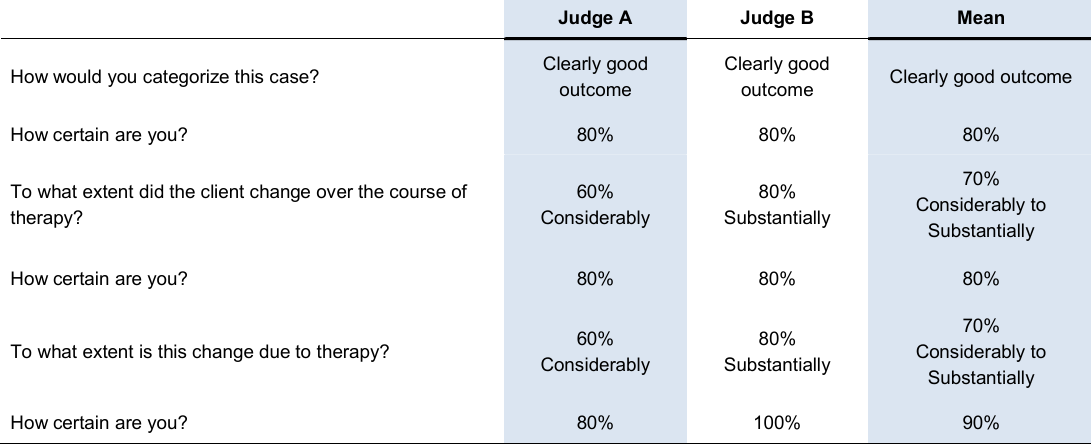
Table 6: Adjudication